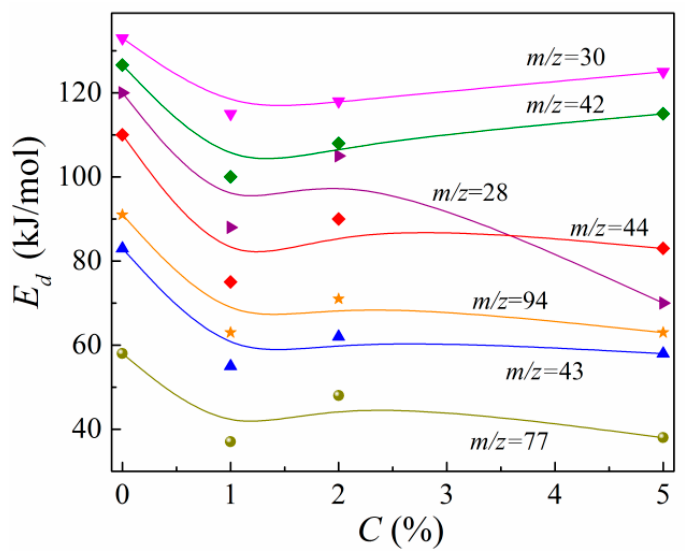
Figure 9. Concentration dependences of the desorption activation energy for volatile thermal desorption fragments with m / z = 28, 30, 42, 43, 44, 77, and 94.